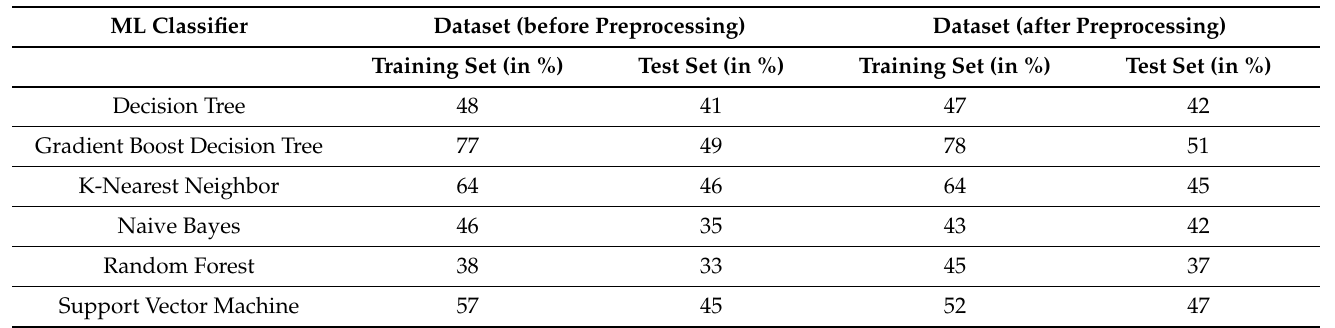
Table 4. Accuracy scored by candidate classifiers with training and test subsets before and after postprocessing of raw dataset.